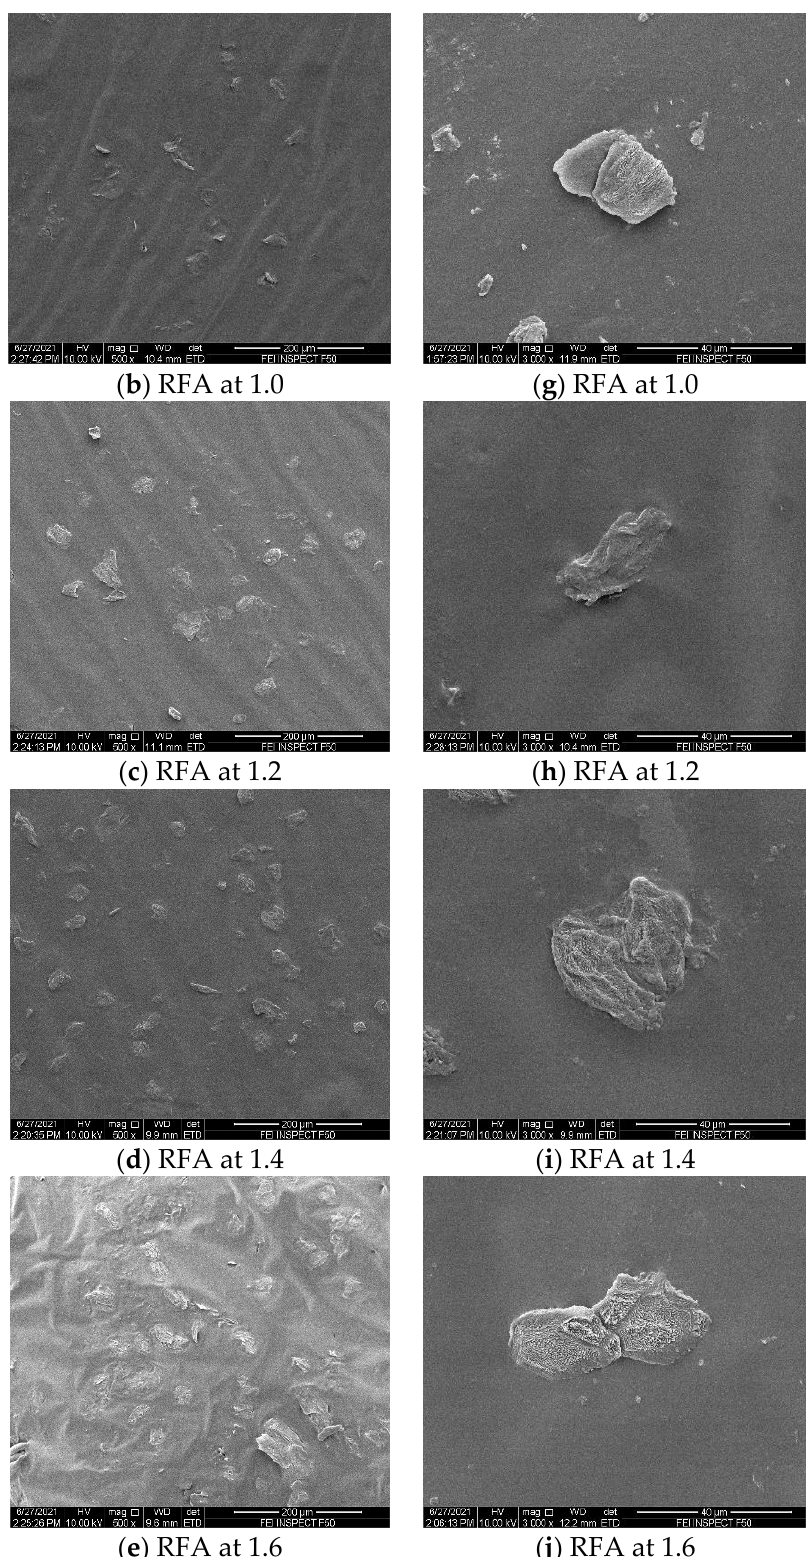
Figure 13. SEM diagram of asphalt mastic with different rates of filler and asphalt.(a-e) 500×,(f- j)3000× ( f – j ) 3000 ×